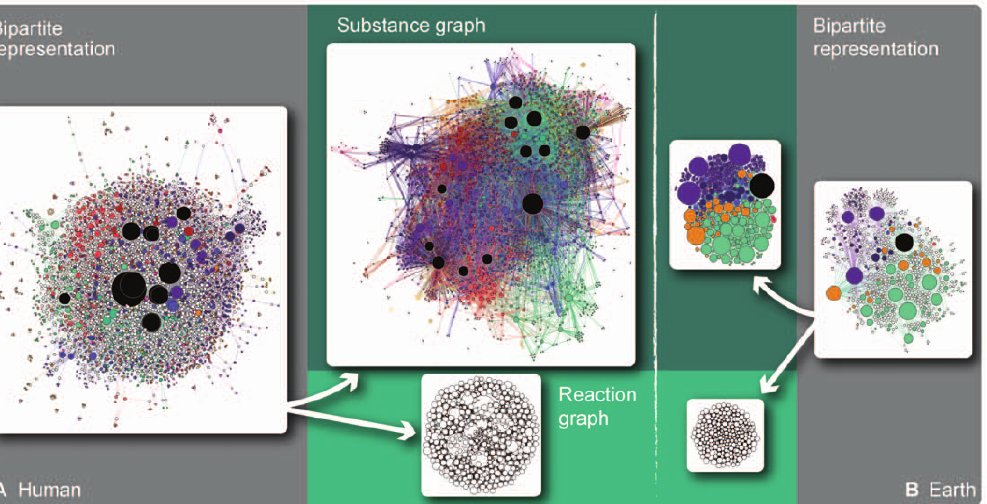
Figure 2. Ridiculograms of the human metabolism and Earth’s atmospheric reaction system in bipartite, substance and reaction graph representations. The areas of the vertices are proportional to their degree. White vertices are reaction vertices; black vertices are currency vertices. For the other vertices the color represent different network modules. The colors of the edges are the same as their vertex of largest degree.